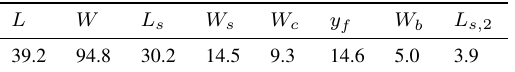
TABLE 2. Design parameters for a CP E-shaped patch design (units in mm)